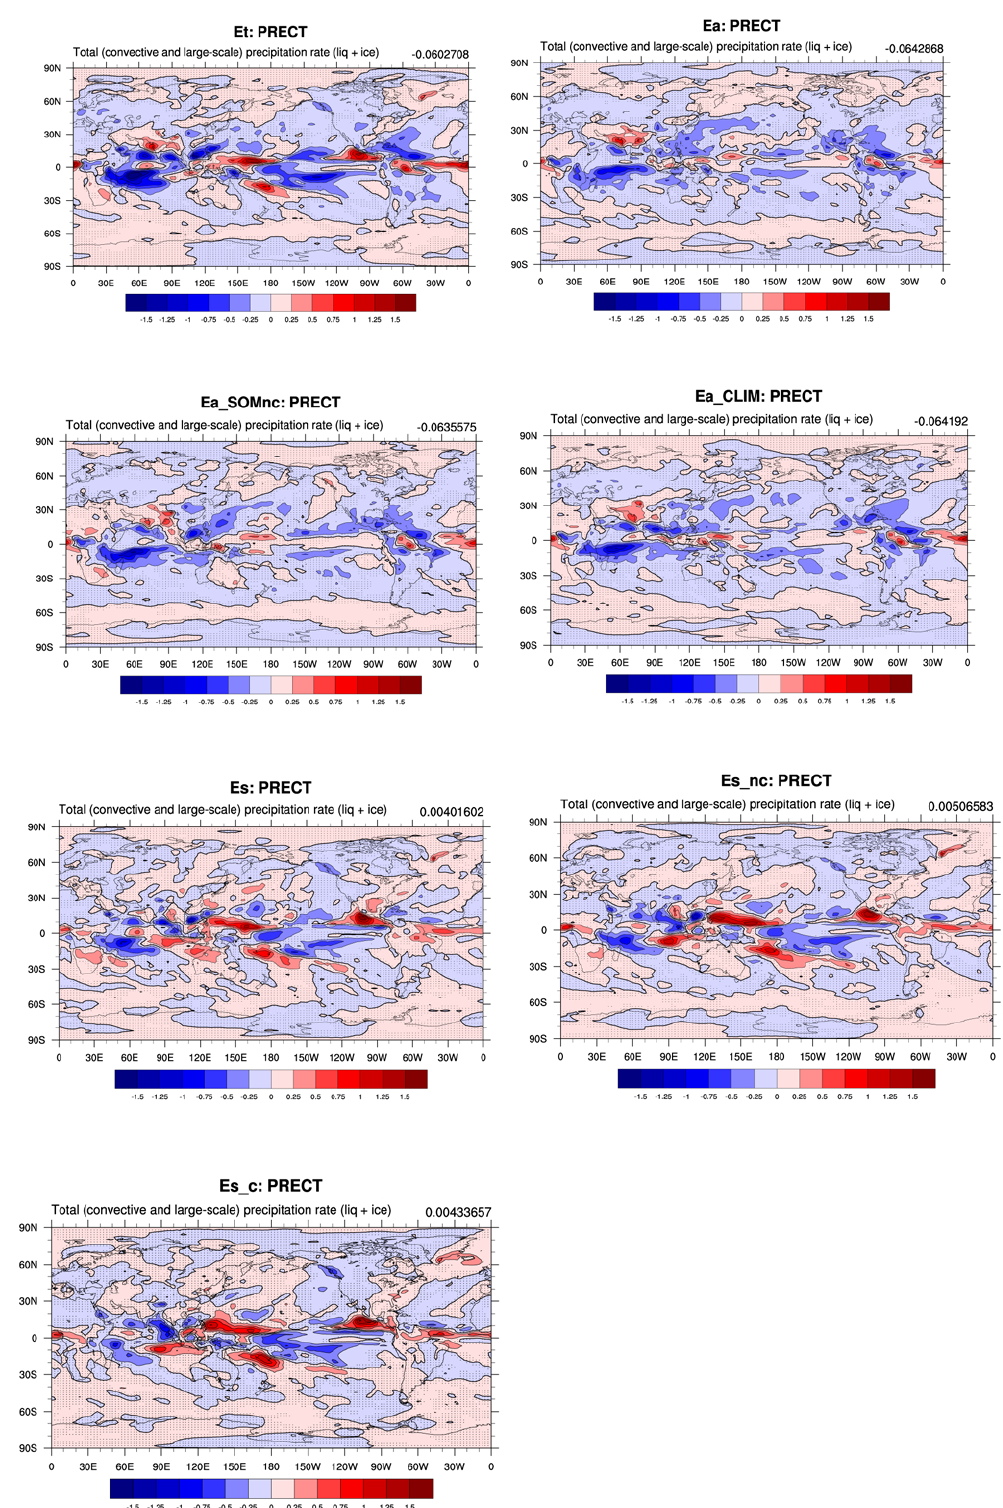
Fig. 5. Same as Fig. 4 but for precipitation. Unit is mmday − 1